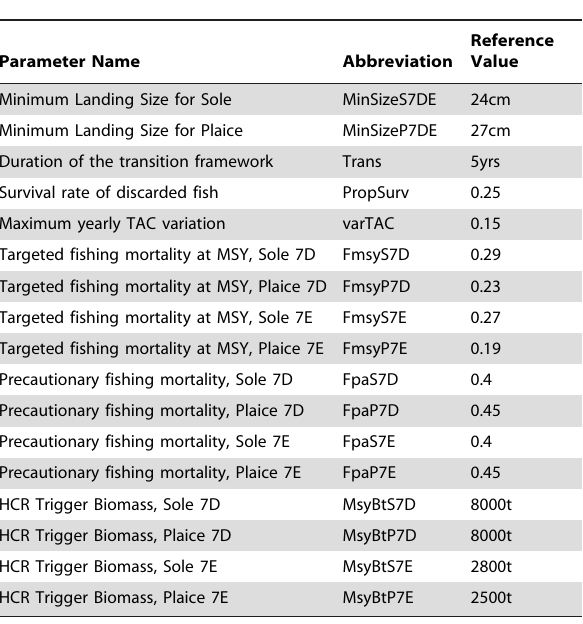
Table 4. Management parameters